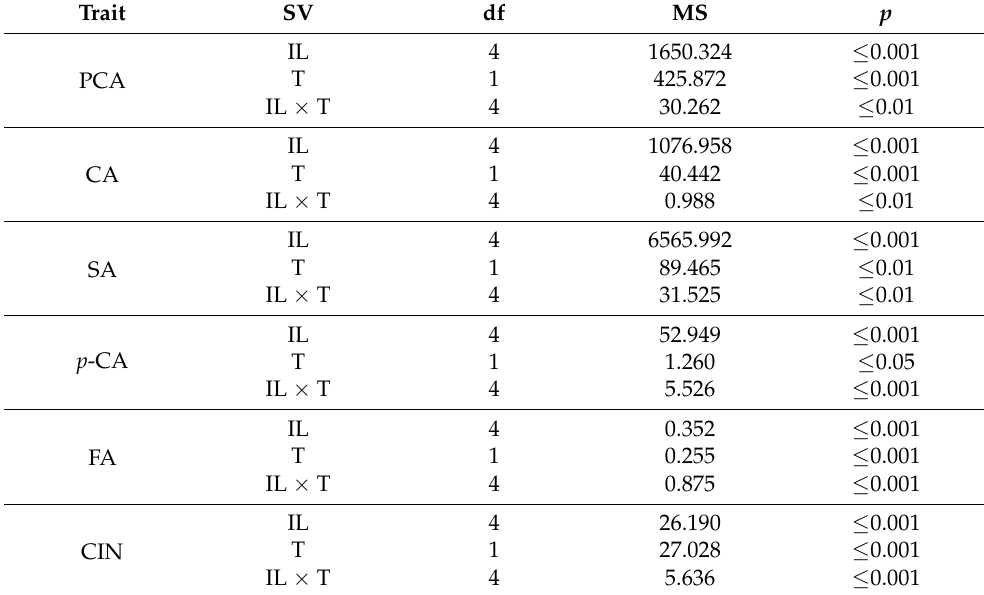
Table 3. Analysis of variance for phenolic acids evaluated in maize inbred lines under different water regimes with two replications per treatment. Abbreviations: PCA: protocatechuic acid; CA: caffeic acid; SA: sinapic acid; p -CA: p -coumaric acid; FA: ferulic acid; CIN: cinnamic acid; SV: source of